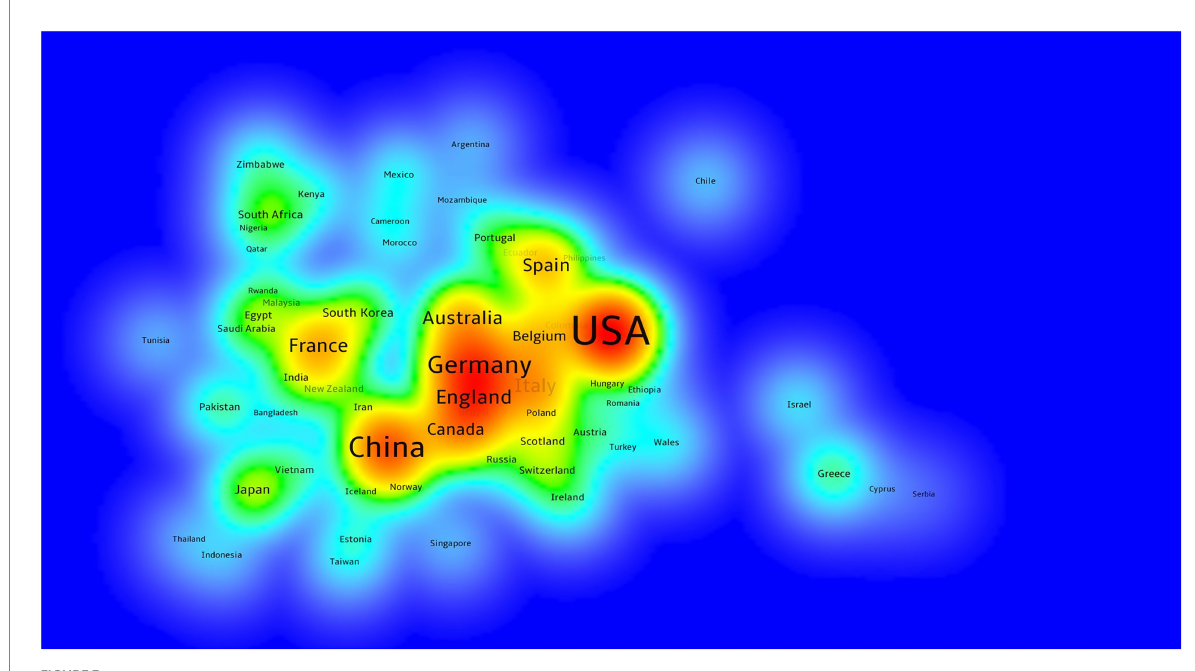
FIGURE 3 Visualization of agricultural multispectral research in terms of the density of cooperation between